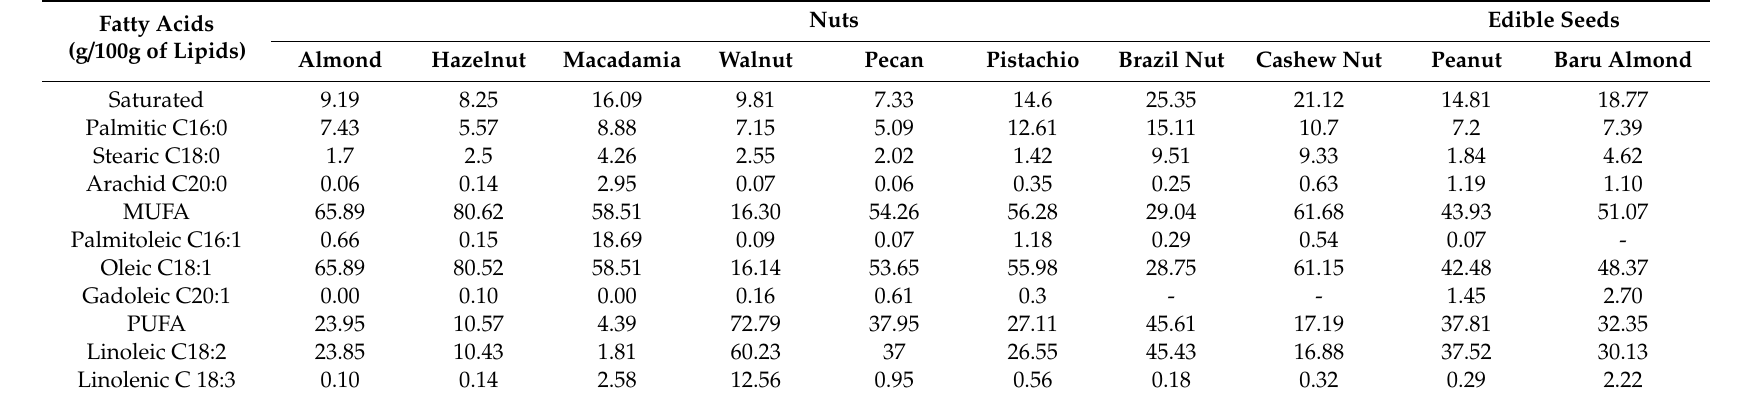
Table 1. Fatty acid composition of nuts and edible seeds.